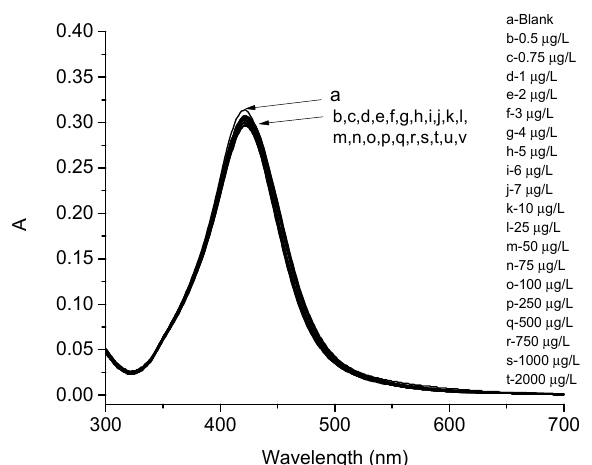
Figure 5. LSPR spectra of colloidal AgNPs after addition of Pb 2+ at different concentrations in the absence of dithizone.